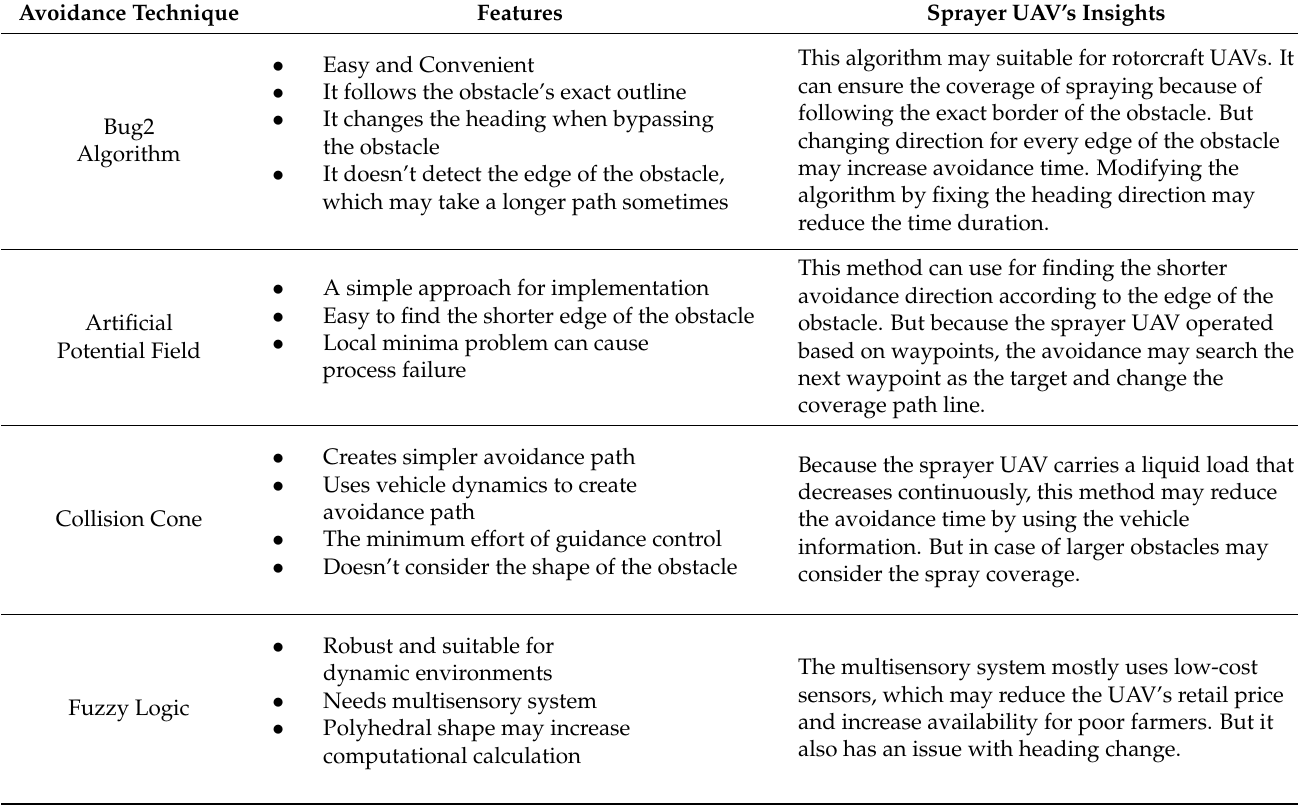
Table 3. Algorithm comparison for sprayer